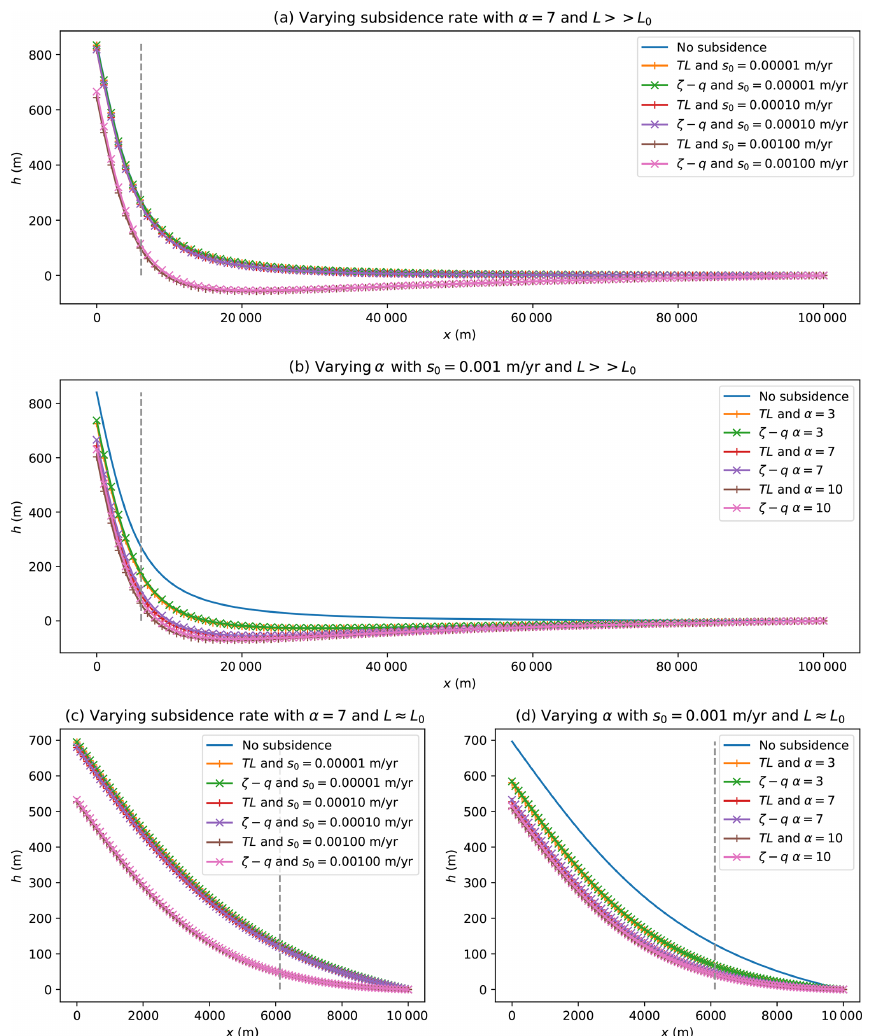
Figure 20. Numerical model experiments comparing the steady-state solutions of modified versions of Eq. (3) (TL model) and Eq. (7) ( ξ – q model) in which subsidence is imposed at a rate s 0 and over an extent controlled by α (see text for details) to the solution without subsidence. In each panel, the dashed line corresponds to x = L 0